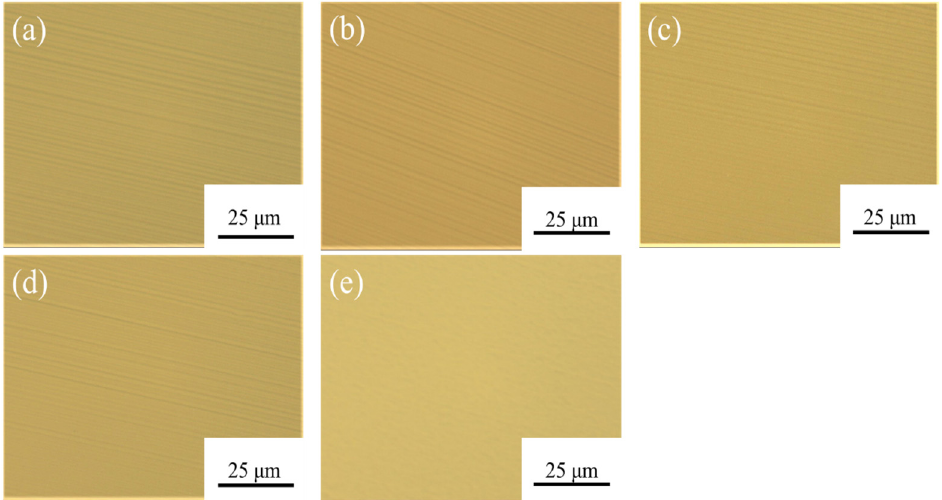
Figure 6. Optical microscope images of 4H-SiC epitaxial wafers with C/Si ratios of ( a ) 0.6, ( b ) 1.0, ( c ) 1.2, ( d ) 1.5, and ( e ) 2.0.